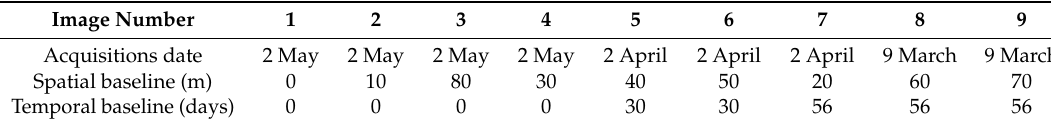
Figure 4. Pauli color composite of a master image of BioSAR data. Points (A, B, C) are analyzed cells in the polarization synthesis. Table 2. The baseline information of the BioSAR dataset.